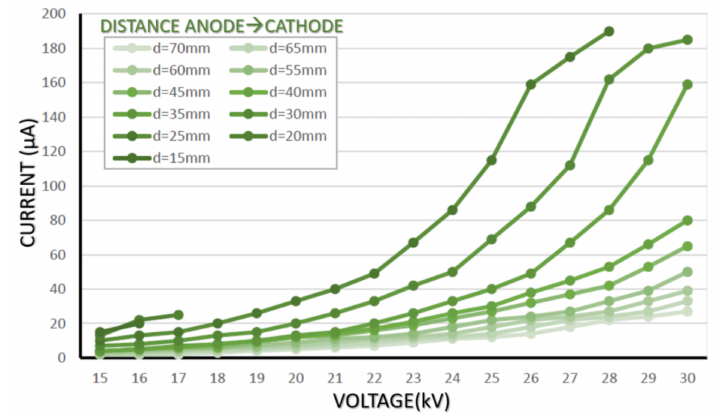
Figure 13. Single thruster: current vs. voltage for different distances between cathode and anode.